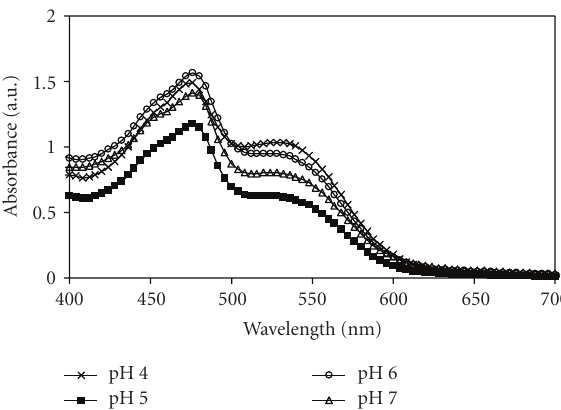
[50, 51] produced 29 μ A cm − 2 J sc . The absorbance of the betalain pigment solution depends on its pH, as shown in Figure 3. Rahman et al. [5] investigated the e ff ect of electrolyte conductivity on OCV and J sc of the ITO/TiO 2 /PVC- LiClO 4 /graphite solar cell. They have shown that both OCV and J sc increase with electrolyte conductivity. From Table